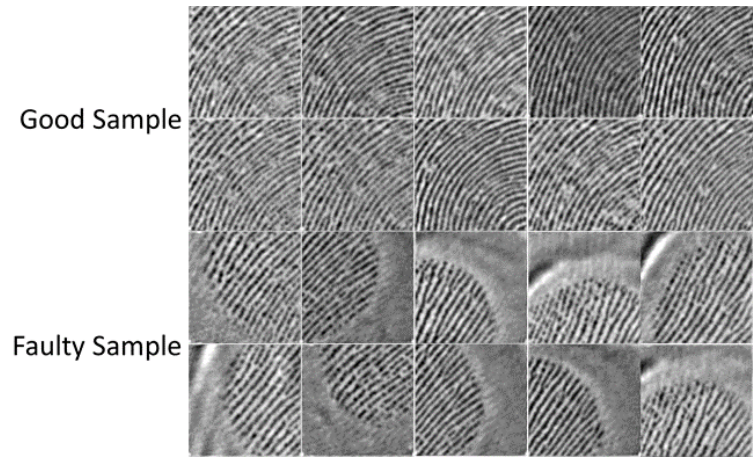
Figure 6. Good and faulty fingerprint images.